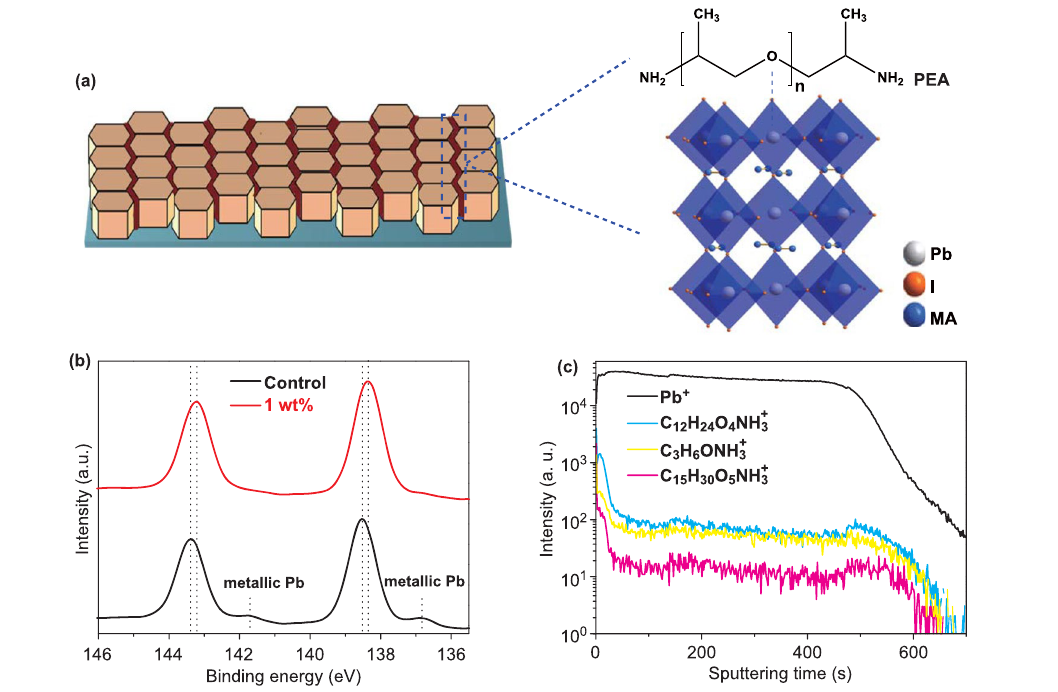
Fig. 1 a Schematic diagram of the GB passivation. b XPS spectra of Pb 4f for the MAPbI 3 films with and without PEA, and c SIMS profiles showing Pb and PEA elements from the top to the bottom of the MAPbI 3 film with